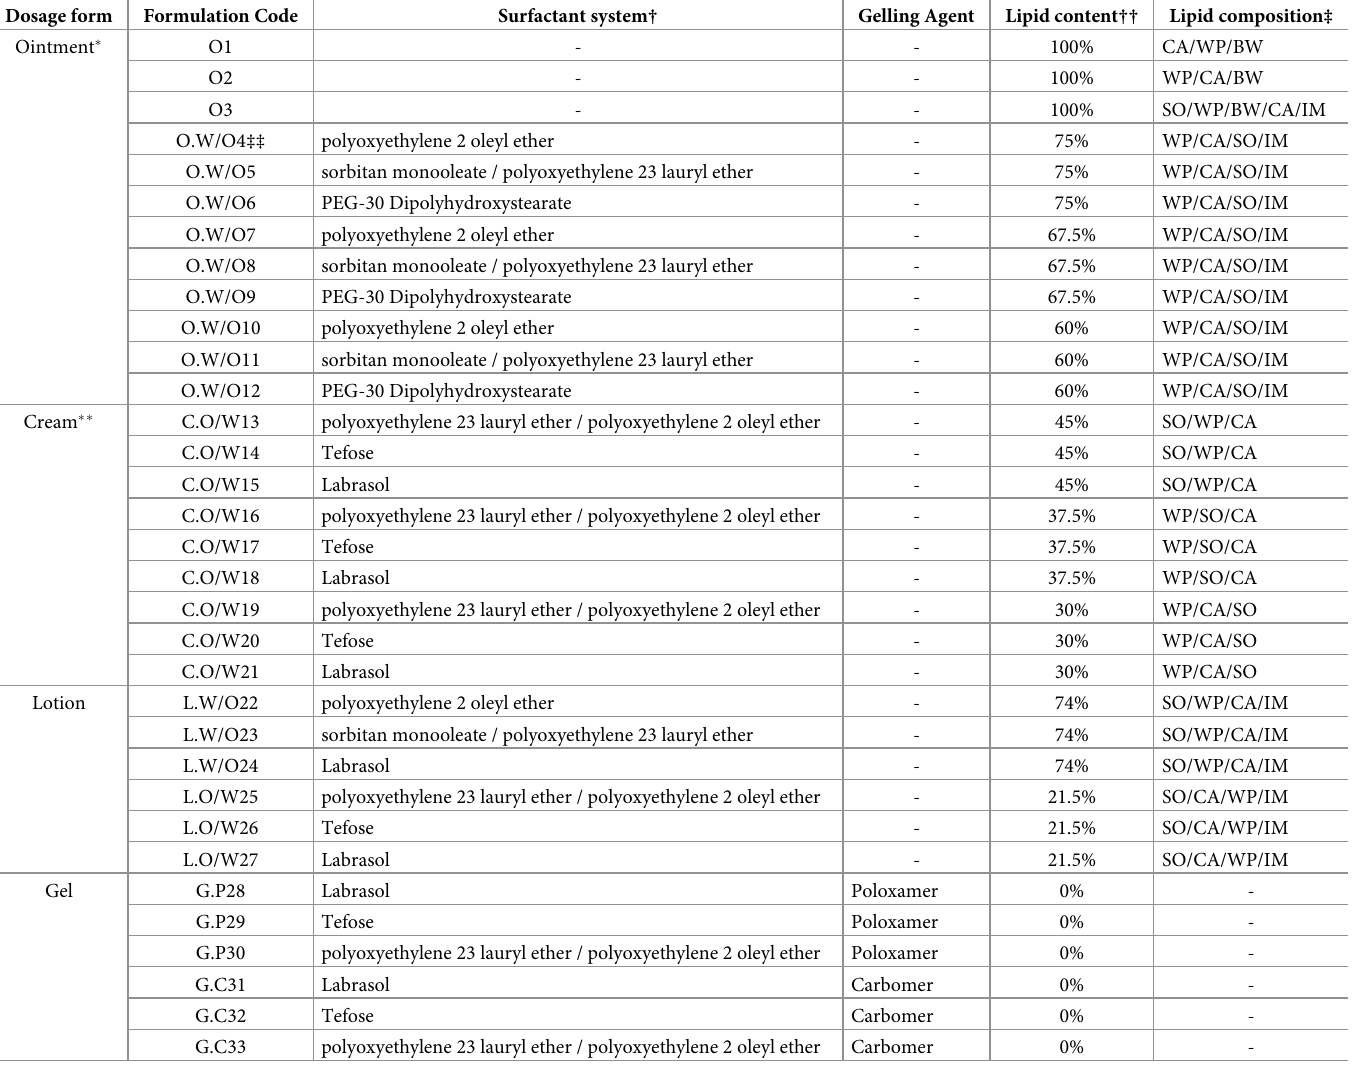
Table 1. Library of formulations studied for dermal delivery of Vitamin K1. Dosage